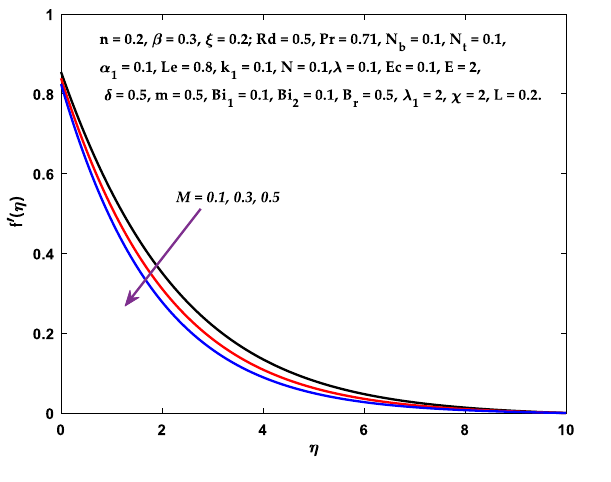
Figure 3. Diagram of M v/s f ′ (η) .